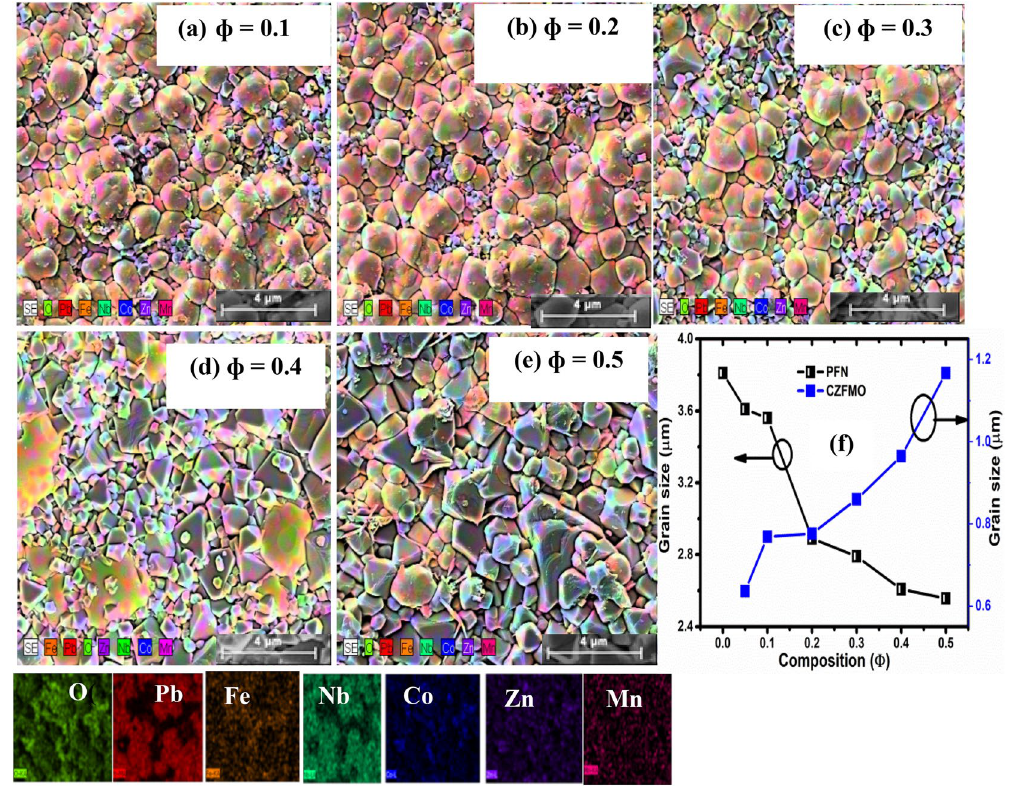
Figure 2. The FESEM micrographs of ( a ) Φ = 0.1 ( b ) Φ = 0.2 ( c ) Φ = 0.3 ( d ) Φ = 0.4 and ( e ) Φ = 0.5 of (1 − Φ)